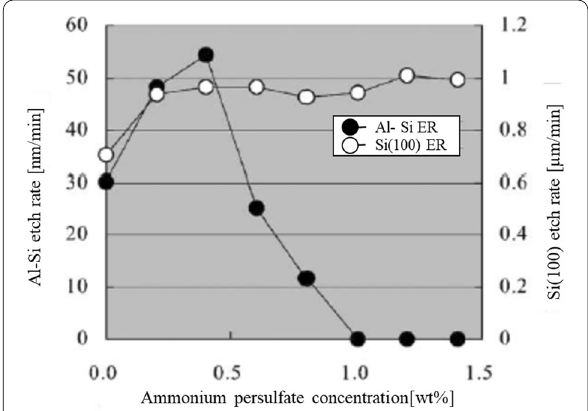
Fig. 26 Etch rate of Al-Si and Si{100} as a function of ammonium persulfate (AP) concentration in 3.2 wt.% Si dissolving 10 wt% TMAH at 80 °C [108], © 2004, Elsevier